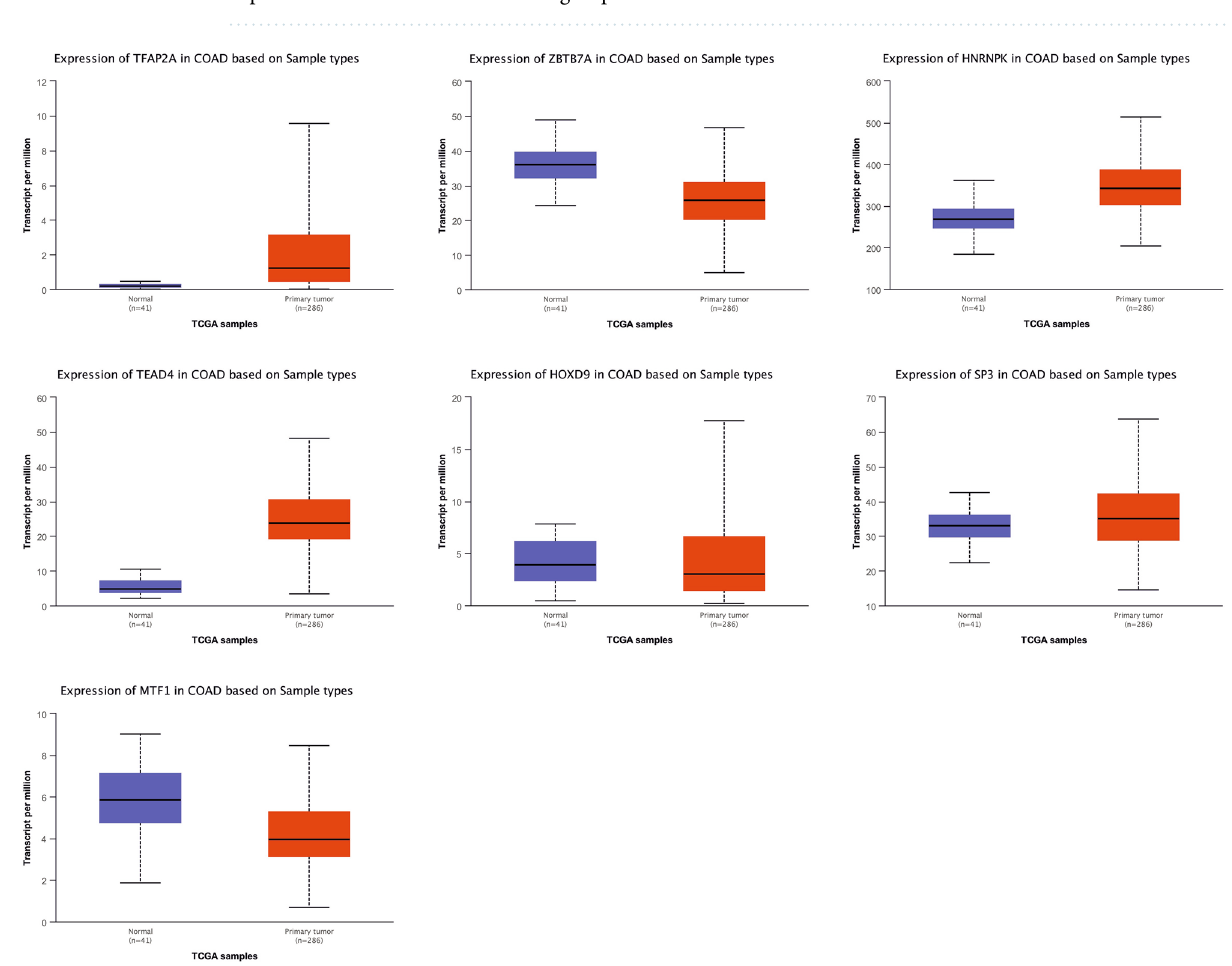
Figure 6. The box-plots show the expression of some of the TFs with statistically significant differential expression in two normal and tumor